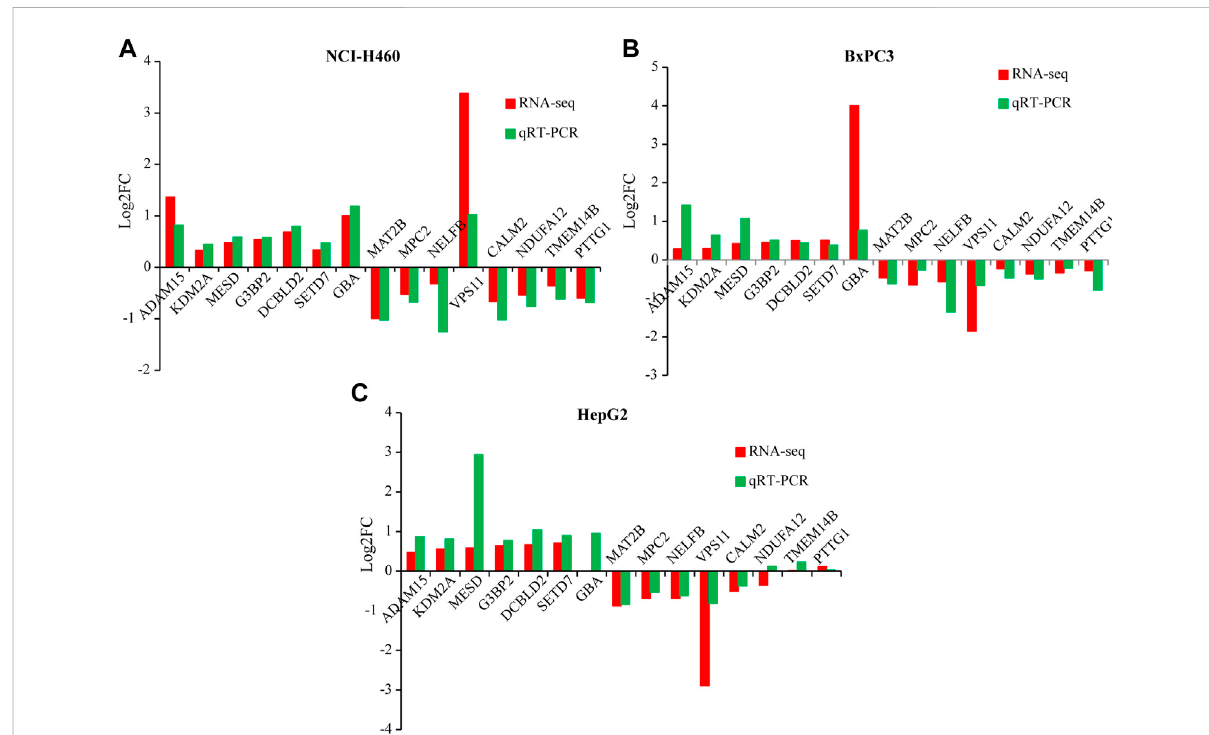
FIGURE 4 TheqRT-PCRresultveri fi edtheDEGsofRNA-seqfromNCI-H460,BxPC3,andHepG2withknockingdown PRR11 ,respectively. (A) NCI-H460, (B) BxPC3, (C)